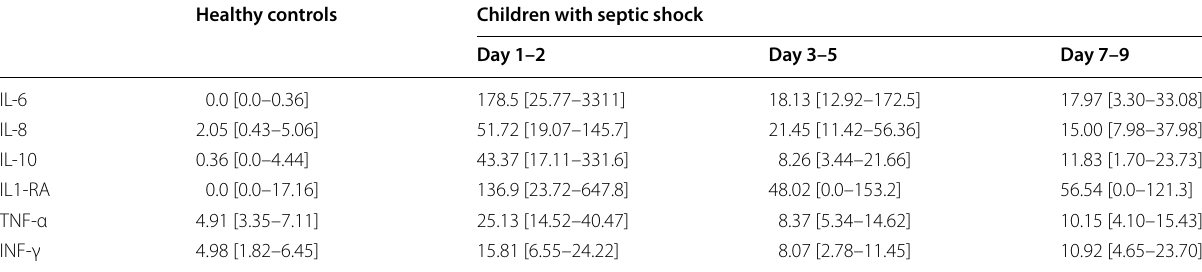
Values (pg/ml) are expressed as median [IQR]. All cytokine values in children with septic shock at all-time points were different from those of healthy controls